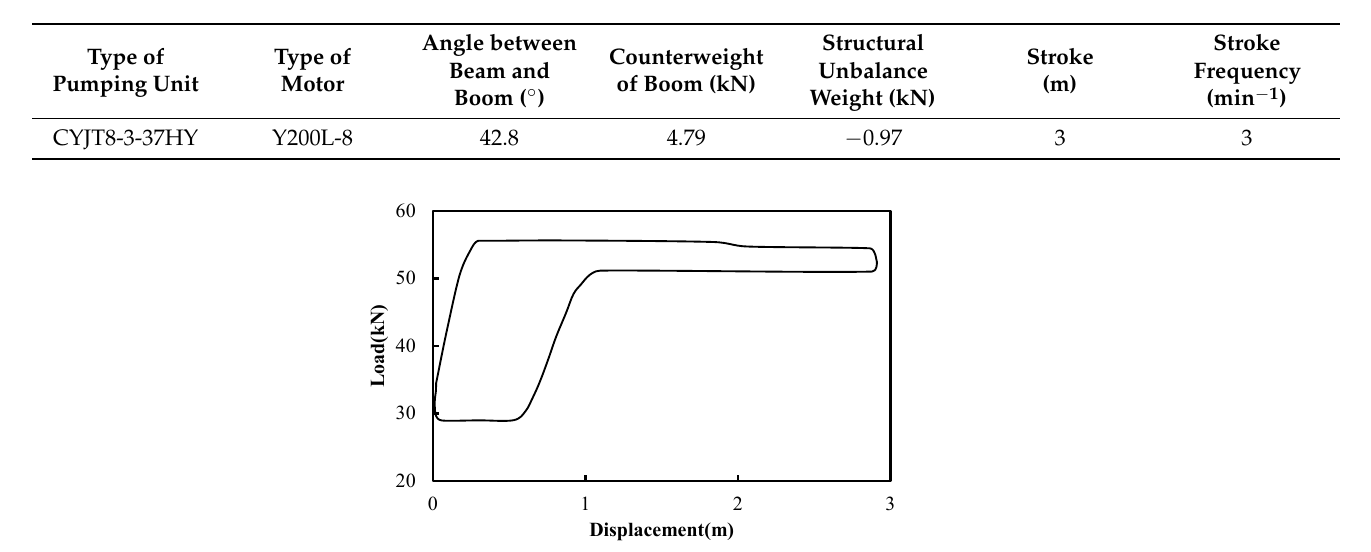
Table 2. Production parameters of well X1.